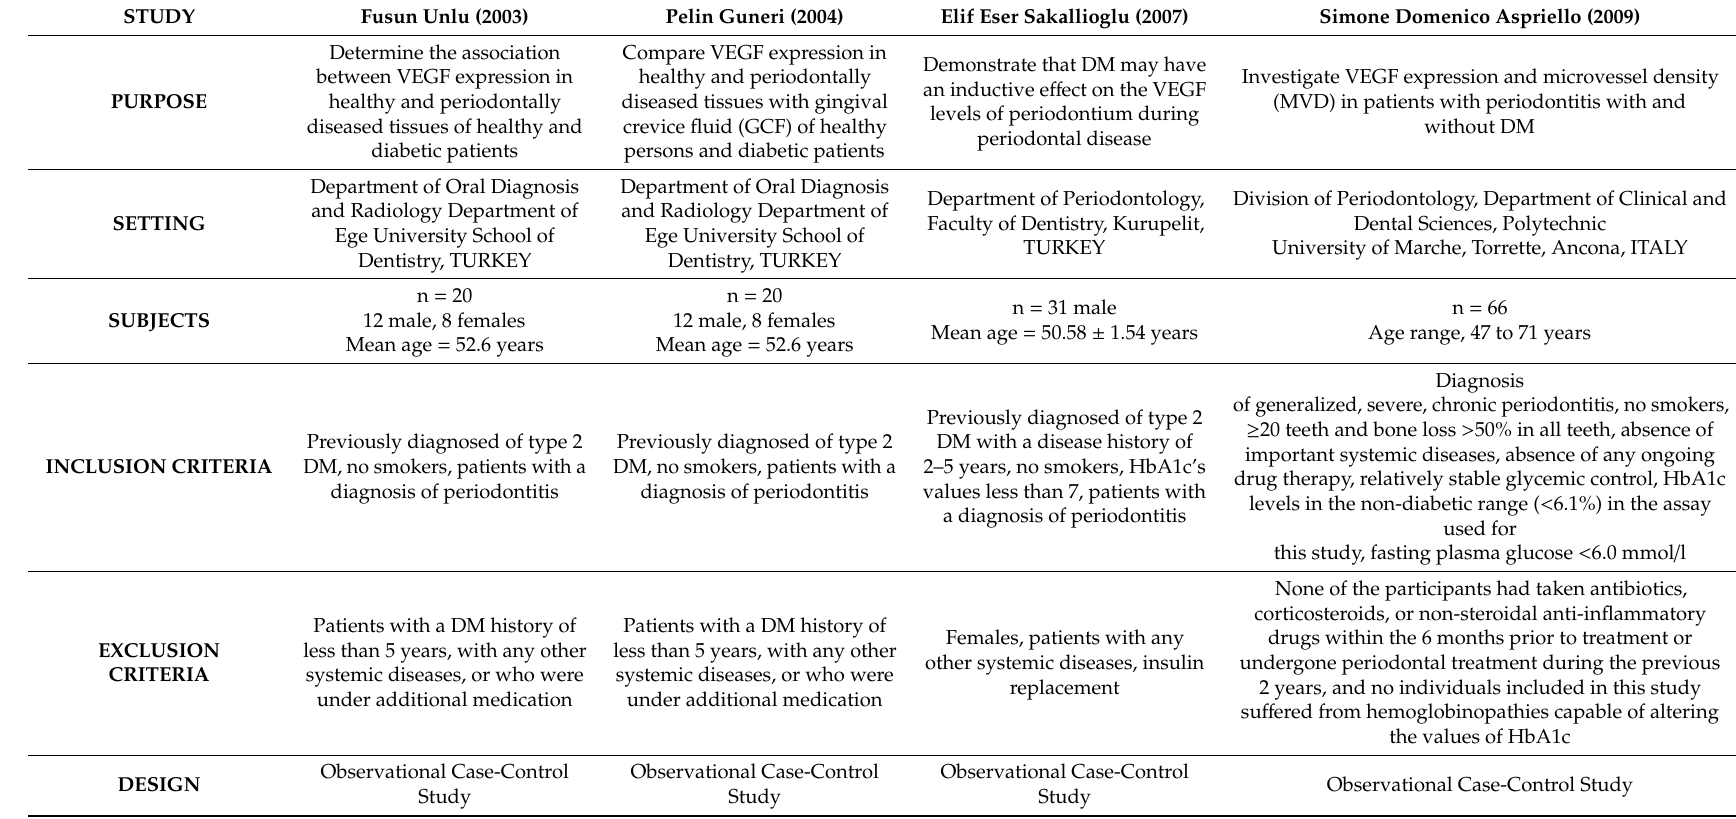
Table 1. Data extraction